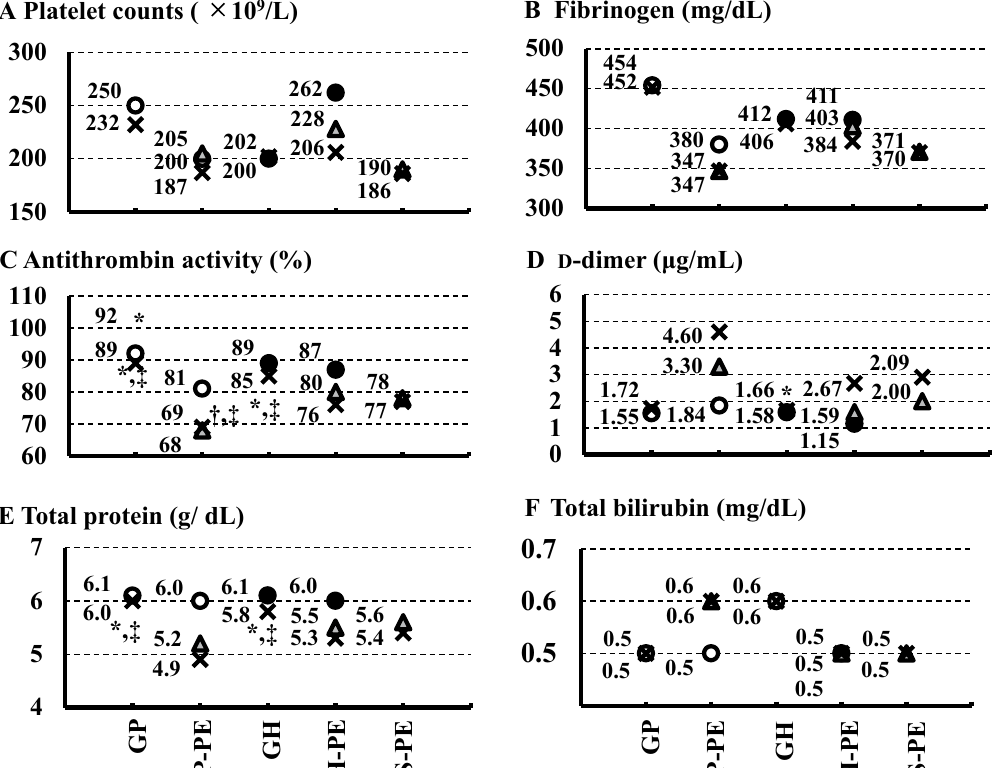
Figure 2. Trends of laboratory findings at onset of gestational proteinuria (GP) or gestational hypertension (GH), onset of preeclampsia, and delivery: platelet count ( A ), fibrinogen ( B ), antithrombin activity ( C ), d-dimer ( D ), total protein ( E ), and total bilirubin ( F ). All data shown are median values (or mean values). ○ , at GP onset (appearance of proteinuria); , at GH onset (appearance of hypertension); ▲ , at preeclampsia onset (hypertension plus proteinuria); ×, at delivery. *P < 0.05 versus proteinuria preceding preeclampsia ● (P-PE); † P < 0.05 versus hypertension preceding preeclampsia (H-PE); ‡ P < 0.05 versus simultaneous onset of proteinuria and hypertension before preeclampsia (S-PE); § P < 0.05 versus